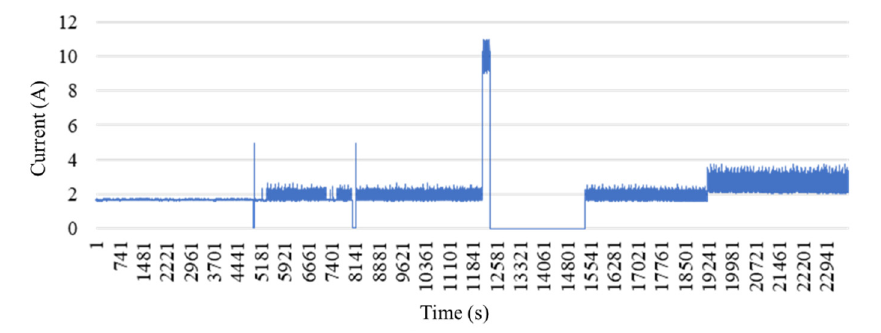
Figure 6. Experimental data.